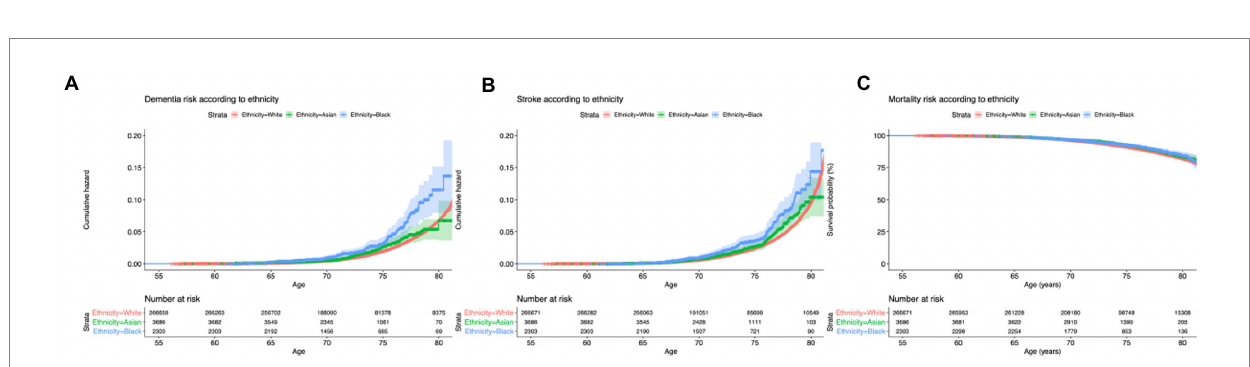
FIGURE 3 Survival curves of the risk of dementia (A) , stroke (B) and mortality (C) , according to age and ethnicity. Red color is for White, green for Asian and blue for black. Colored area represents the